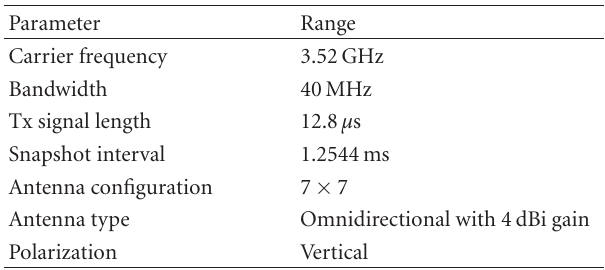
Table 1: The configurations of THU MIMO channel